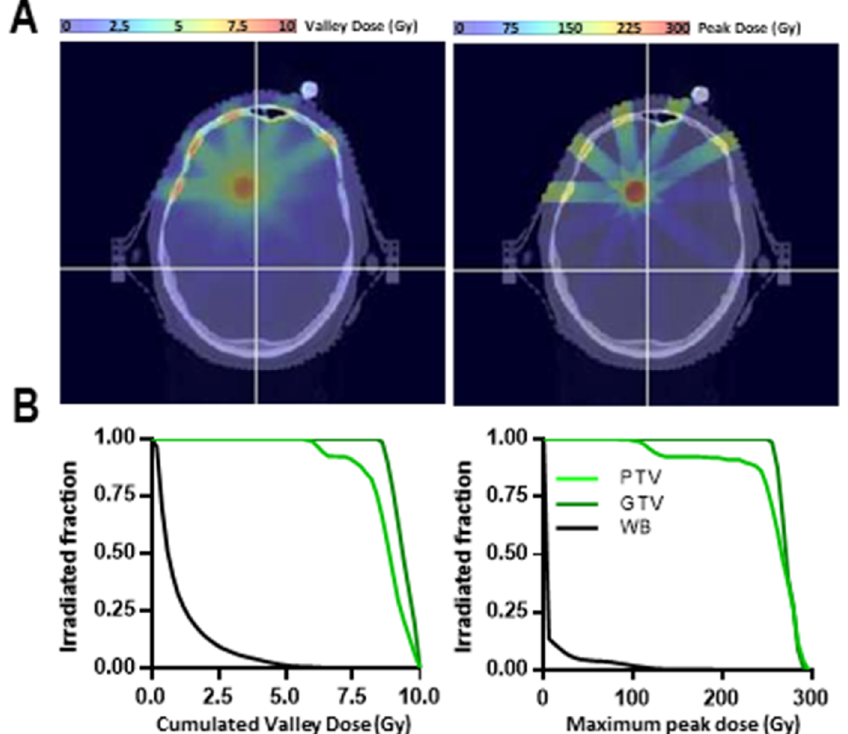
Figure 5. Exploratory treatment plan and provisional dosimetry for MRT (10 Gy, 5 ports) for brain metastasis irradiation for a human patient. ( A ) Valley and peak dose maps to deliver a 10 Gy cumulated valley dose to a 1 cm brain metastasis in a human patient through 5 MRT ports. ( B ) DVHs obtained for whole brain (black), PTV (light green), and GTV (dark green).